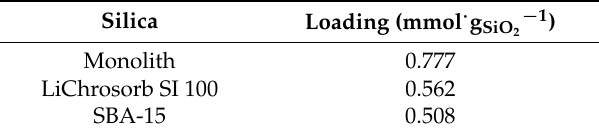
Table 2. Functionalization of silicas with trimethoxysilane.